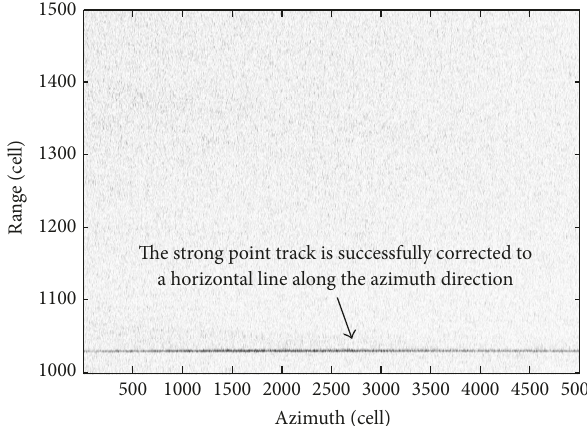
Figure 11: CF-RCMC result (bistatic radar). The RCM can be easily and successfully corrected.